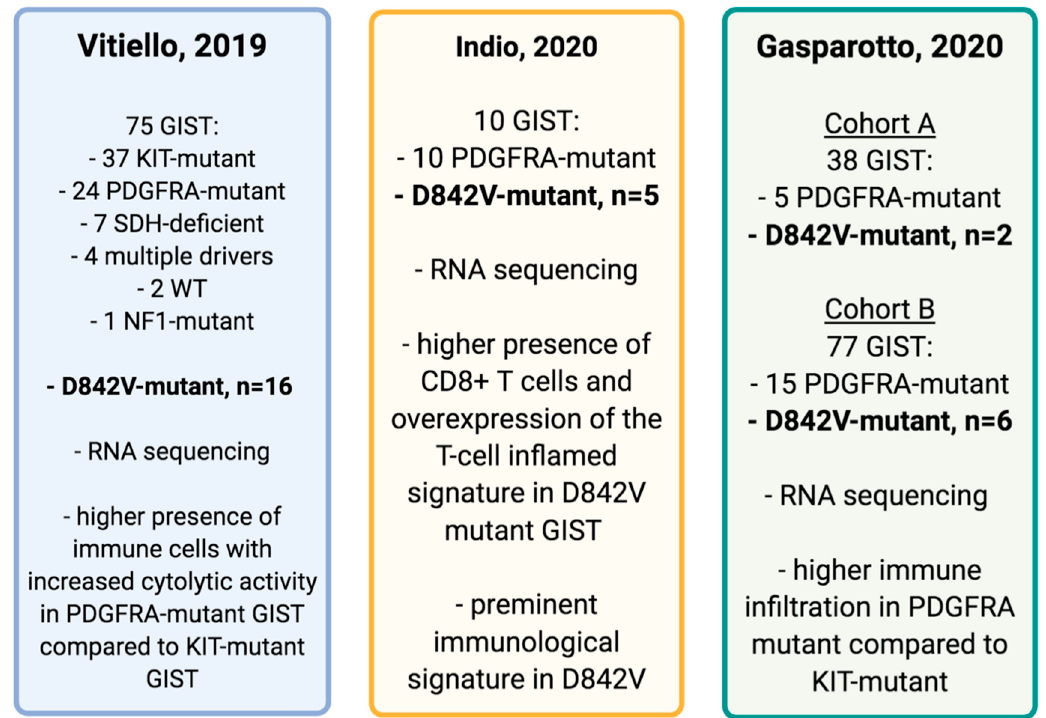
Figure 2. Schematic figure reporting molecular findings of recent immune-profiling studies on GIST, including D842V mutant malignancies [36–38]. Abbreviations: GIST: gastrointestinal stromal tumors; n: number; PDGFRA: platelet-derived growth factor receptor A; WT: wild type.